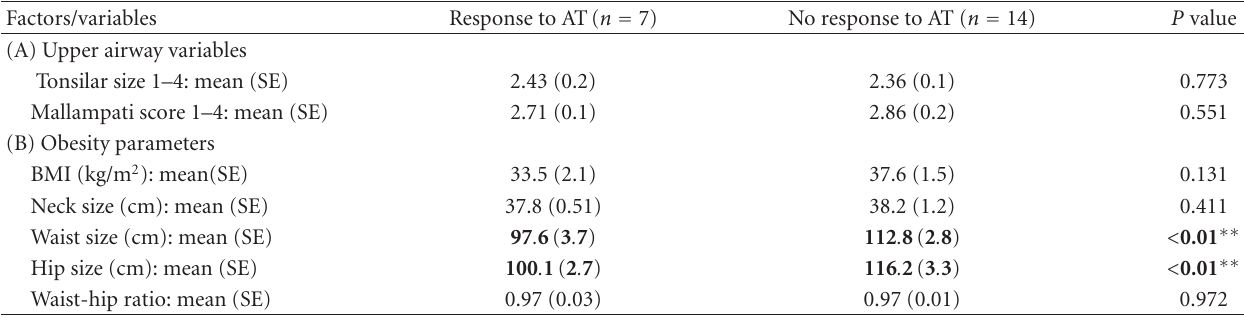
Table 2: Upper airway and obesity variables. For quantitative variables, data are presented as mean ± standard error (SE). BMI: body mass index. P values are obtained by two-sample t